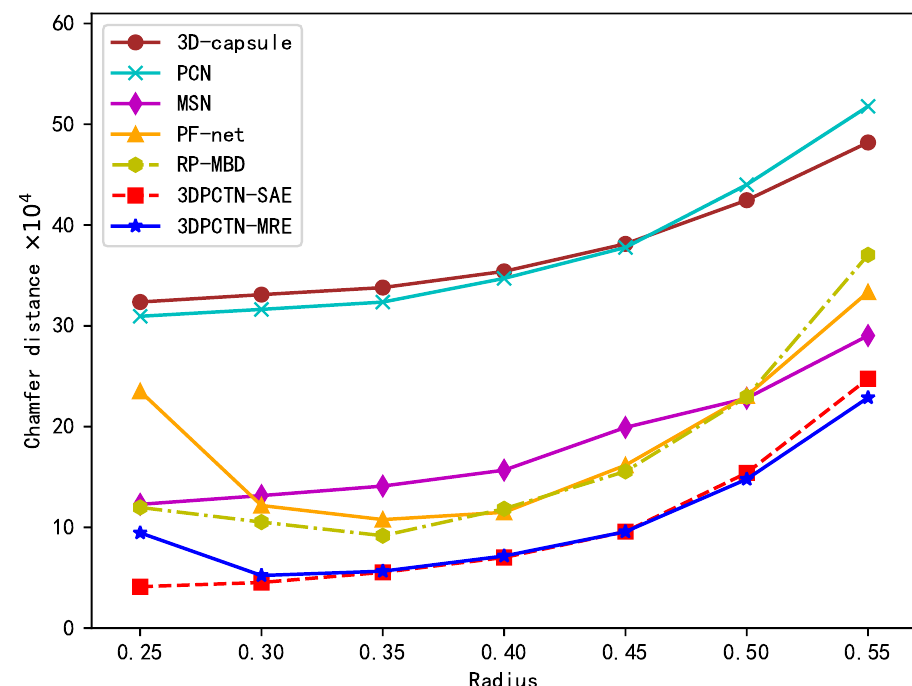
Figure 9. Robustness against the variable size of missing parts. Our methods are robust when the size of the missing part is similar to the size of the trained missing part. A smaller value of CD indicates a better